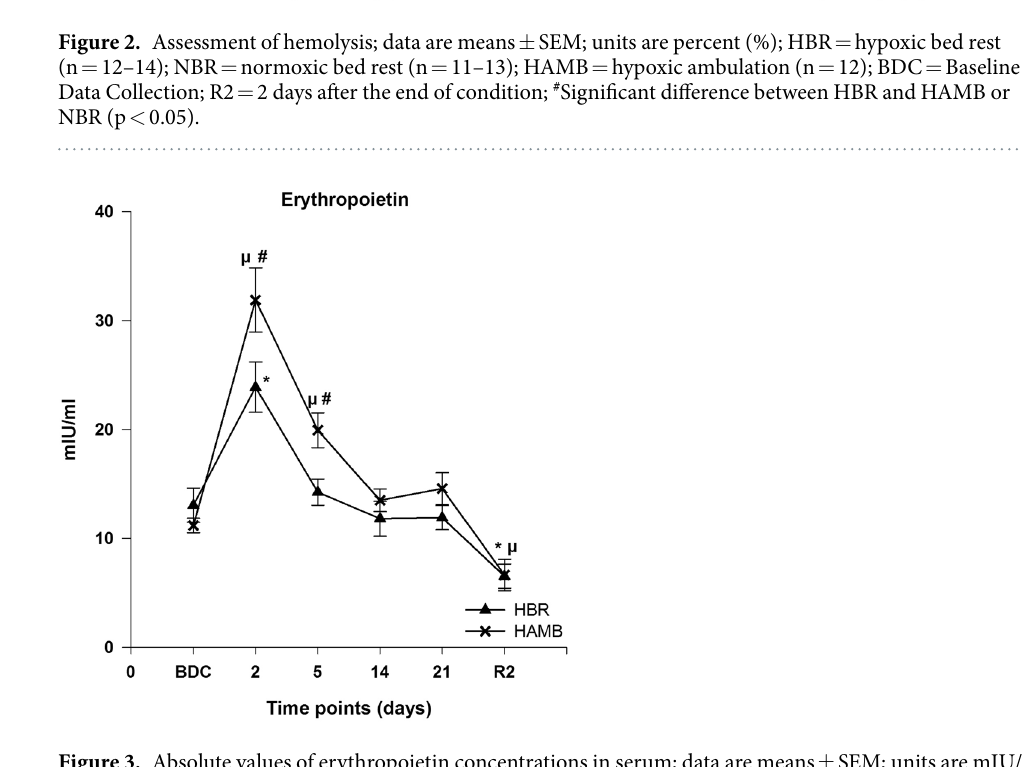
Figure 3. Absolute values of erythropoietin concentrations in serum; data are means ± SEM; units are mIU/ ml; HBR = hypoxic bed rest (n = 11); HAMB = hypoxic ambulation (n = 11); BDC = Baseline Data Collection; R2 = 2 days after the end of condition; # Significant difference between HBR and HAMB; * Significant difference to BDC in HBR; µ Significant difference to BDC in HAMB (p <